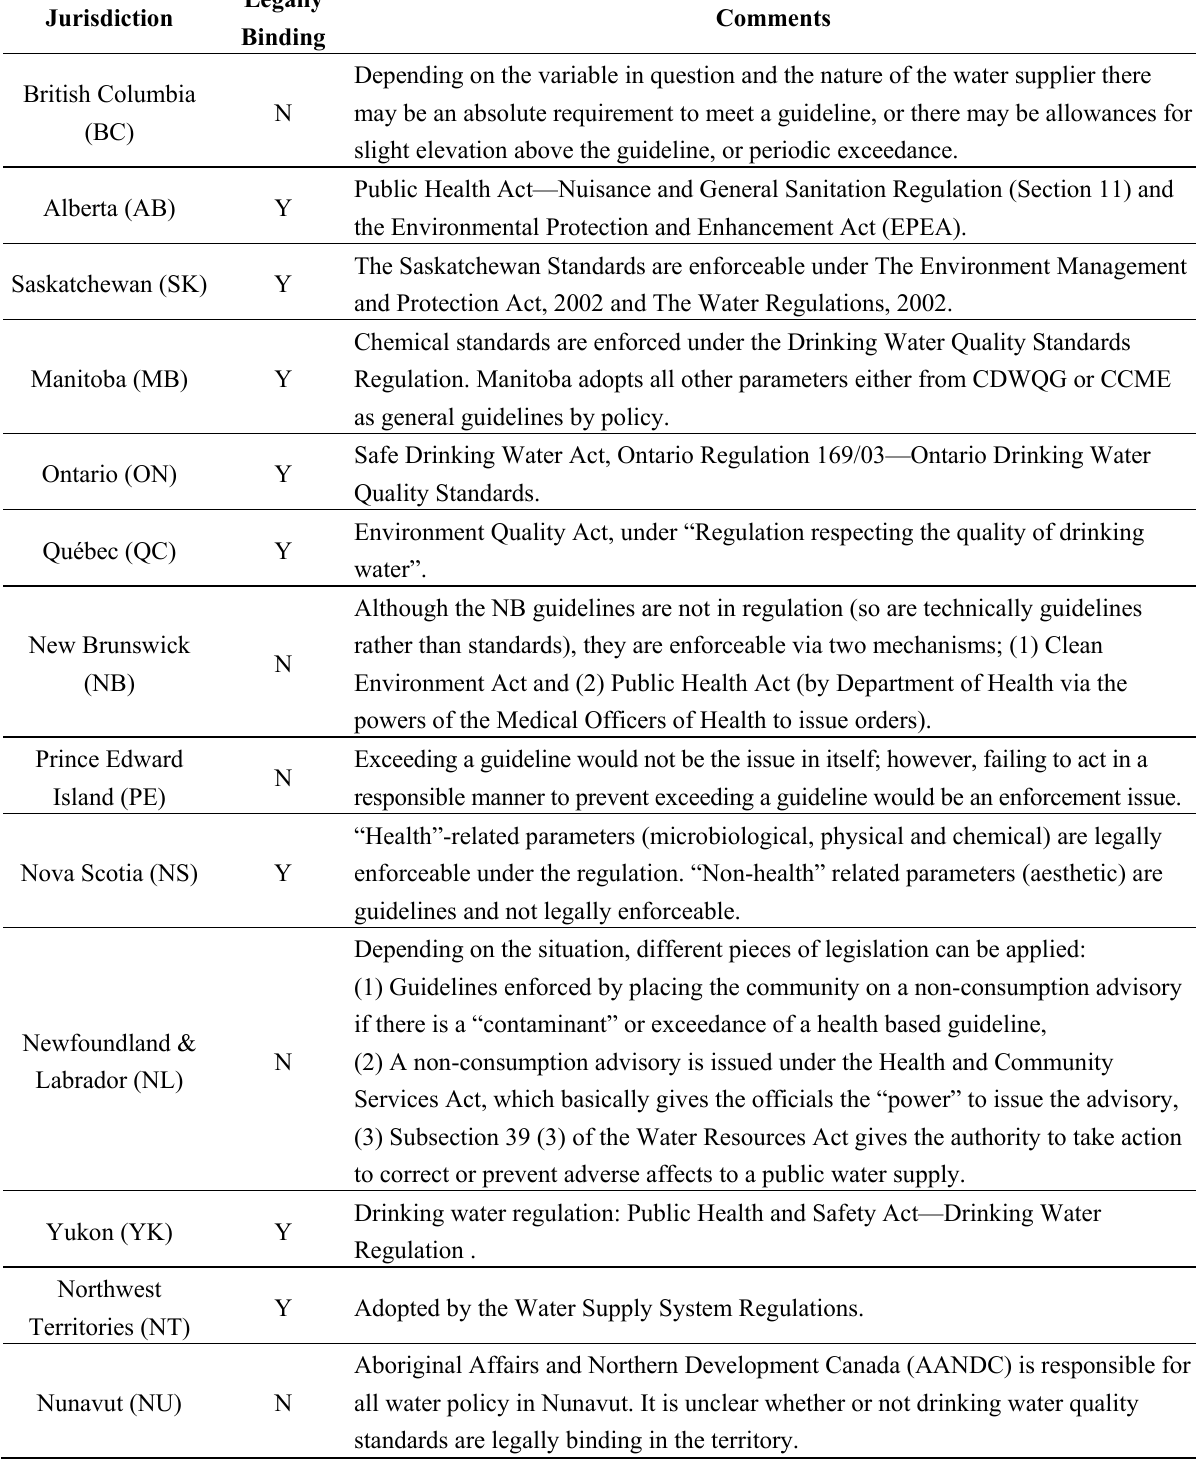
Table 1. Legal enforcement of drinking water